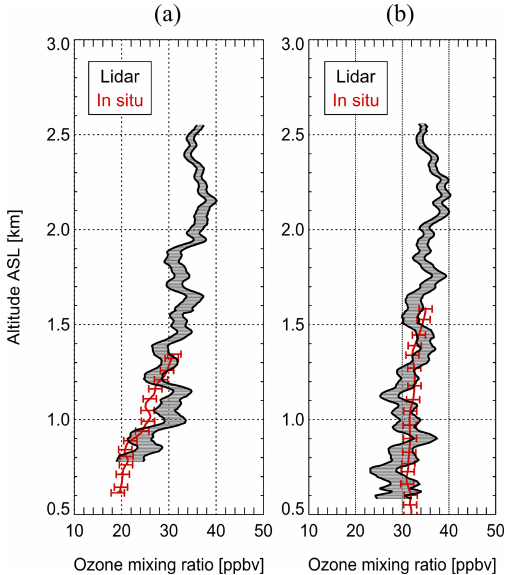
Figure 15. A comparison between the in situ and the lidar-derived O 3 mixing ratio for the measurements taken in (a) polluted air and (b) unpolluted air. Grey shading represents the sum of the random uncertainty in the lidar signal detection and the range of possible aerosol corrections. The locations of the measurements are indi- cated in Fig. 14 as points A and B for panels (a) and (b) respec- tively.